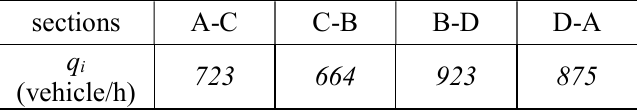
Table 5. Vehicle flow per section of intersection in the period